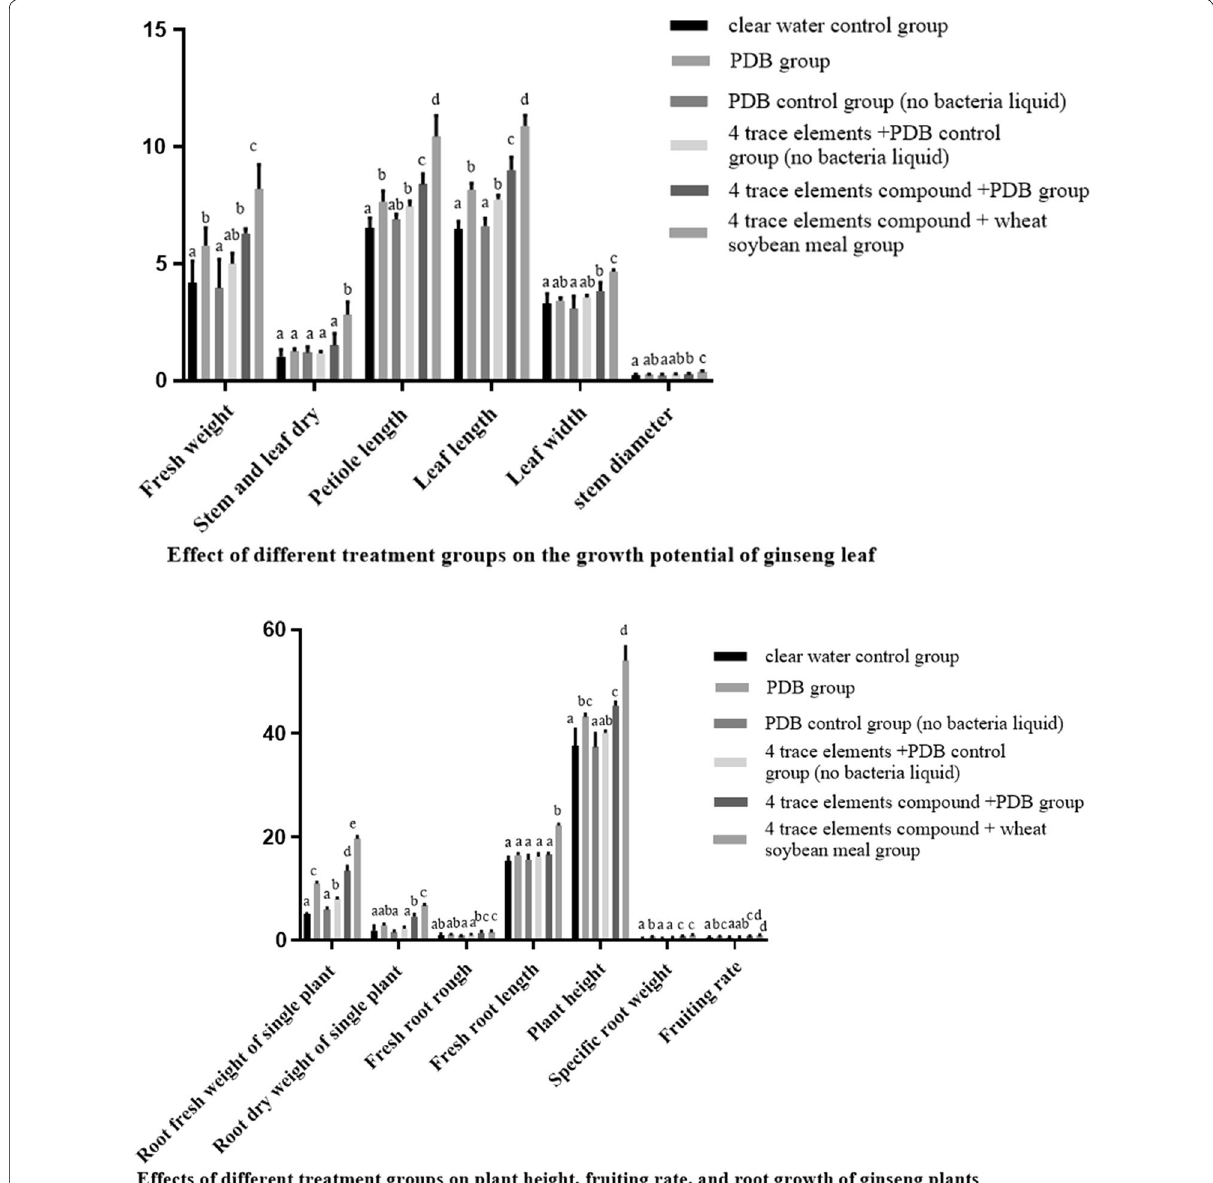
Fig. 4 Effects of different treatment groups on leaf growth potential, plant height, fruiting rate and root growth of